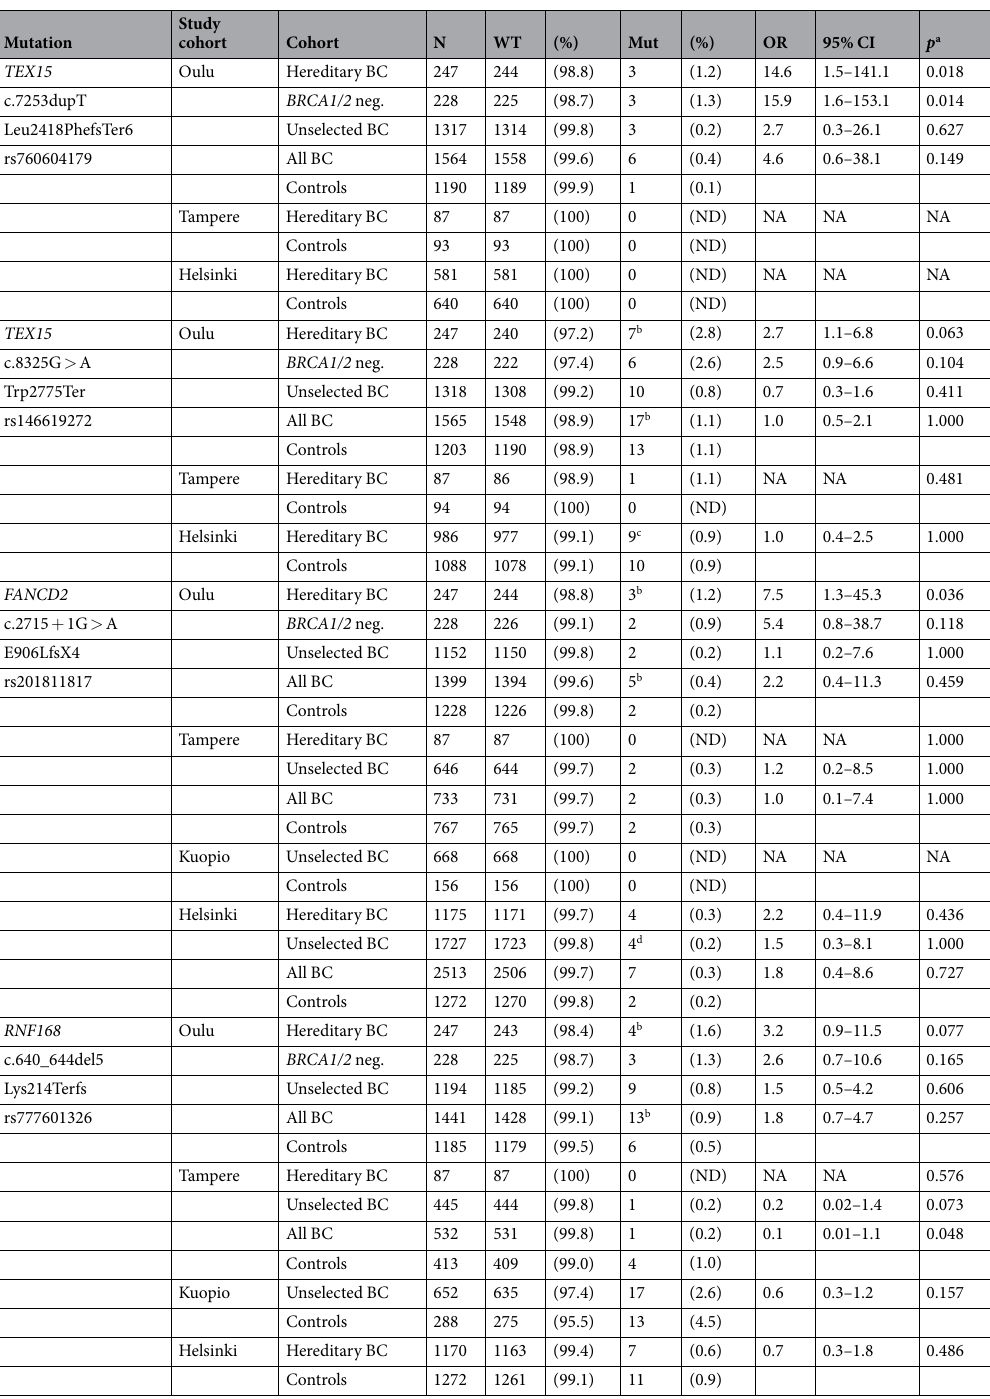
Table 1. Frequency of TEX15 , FANCD2 and RNF168 mutations in the studied Finnish case-control cohorts. a p -value of χ 2 test or Fisher’s exact test, b one BRCA1/2 carrier, c one homozygote, d 416 of the hereditary patients belong also to the unselected cohort, includes one carrier. BC: breast cancer, BRCA1/2 neg: includes only the hereditary cases negative for pathogenic BRCA1/2 mutations, CI: confidence interval, Mut: mutation